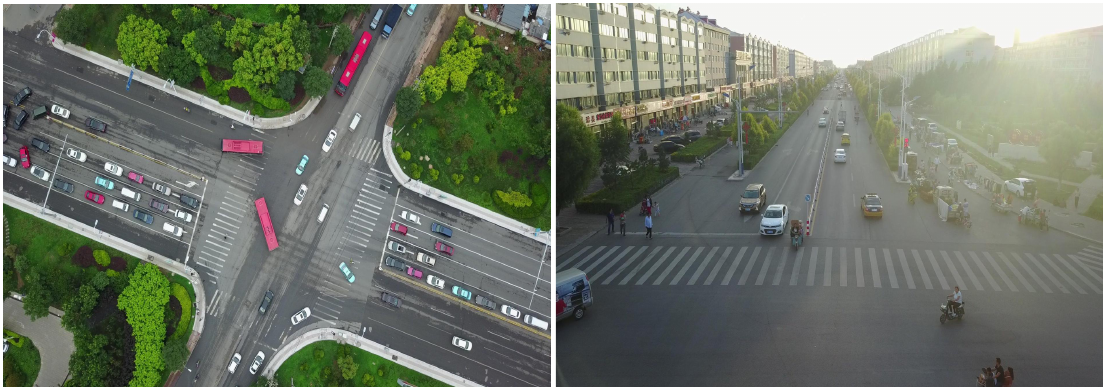
Figure 4. The class distribution in Visdrone VID-Train, Val Dataset.